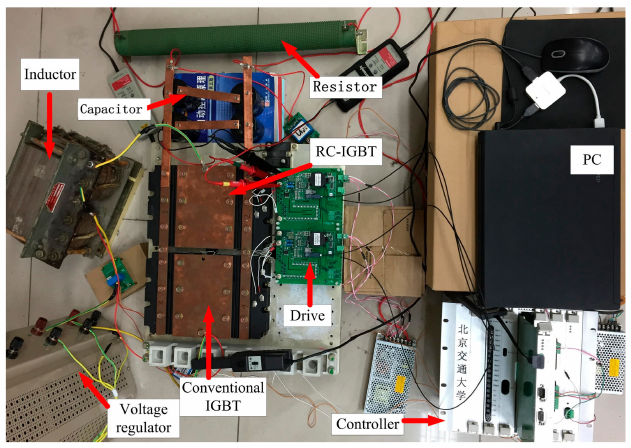
Figure 17. Experimental Bench.